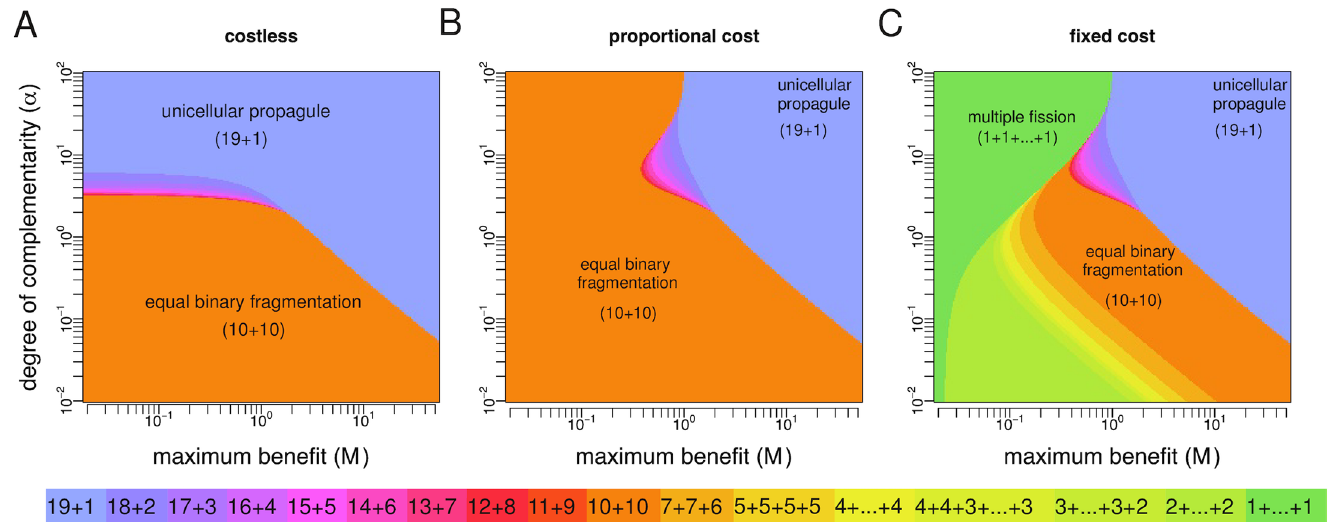
Fig 7. Optimal life cycles under monotonic survival landscapes. Death rates are given by d i = M (1 − g i ) where g i = [( i − 1)/( n − 2)] α . A Costless fragmentation, n = 20. B Fragmentation with proportional costs, n = 21. C Fragmentation with fixed costs, n = 21. For costless fragmentation and fragmentation with proportional costs, only binary modes 19+1, 18+2, ... , 10+10 are optimal. In these cases, diminishing returns to scale ( α < 1) make equal binaryfragmentation (10+10) optimal. Also, optimalityof the unicellular propagulestrategy (19+1) requiresincreasing returns to scale ( α > 1). For fragmentation with fixed costs, nonbinarymodes 7+7+6, ... ,1+ ... +1 can also be optimal.